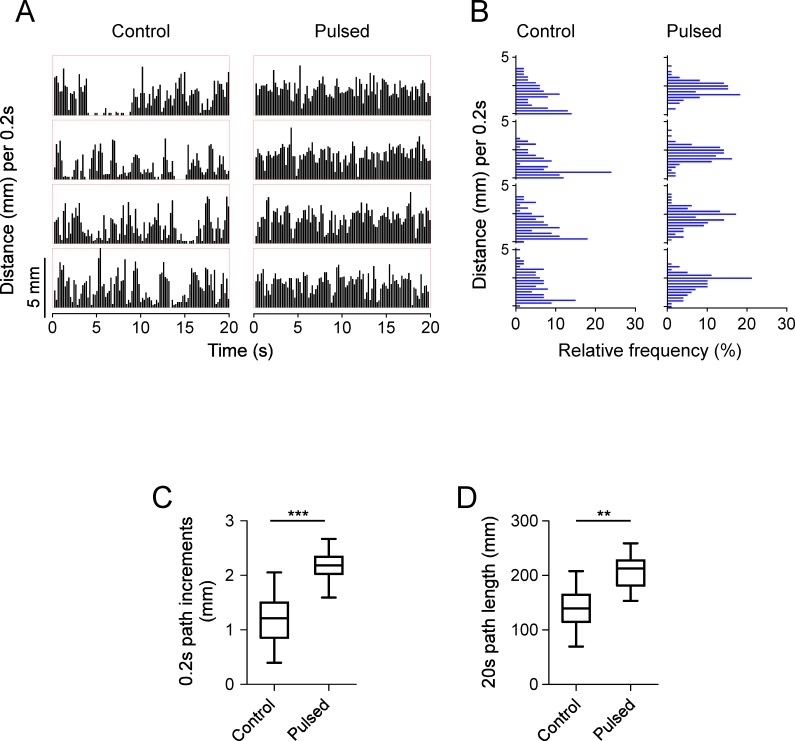
Increased path increments and travel distance in w1118 male flies after pulsed light stimulation.(A) Distances travelled every 0.2 s are plotted during 20 s of locomotion. (B) Relative frequency (%) of the 0.2 s path increments (with bin widths of 0.25 mm) in control and pulsed w1118 flies. (C) 0.2 s path increments in control (n = 8) and pulsed (n = 8) w1118 flies. Asterisks (***) indicate P < 0.001 by Mann-Whitney test. (D) 20 s path length in control (n = 8) and pulsed (n = 8) w1118 flies. Asterisks (**) indicate P < 0.01 by Mann-Whitney test.